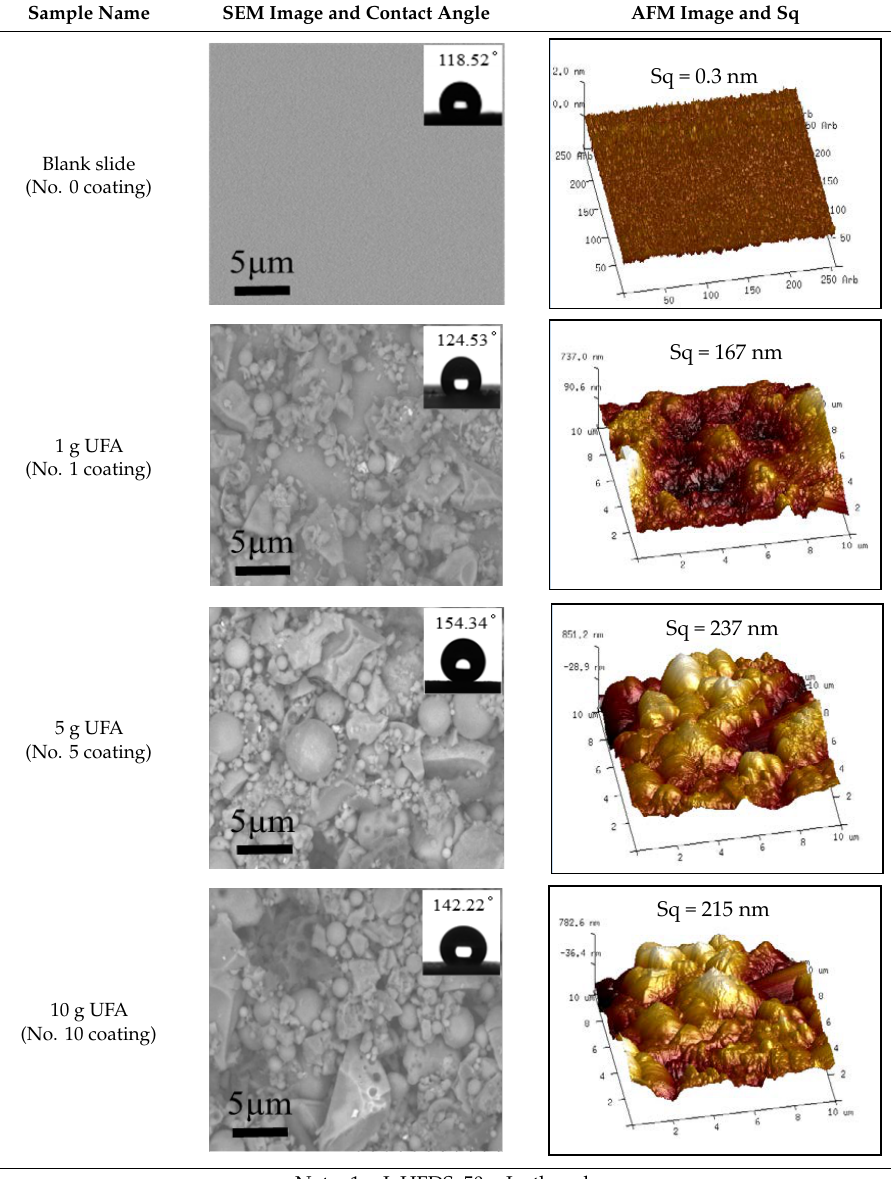
Table 2. Surface morphologies and 3D structures of several representative coatings.